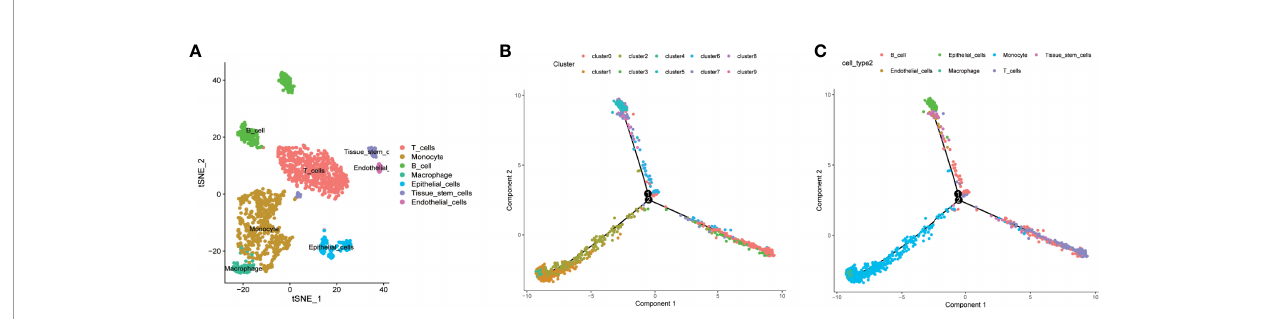
FIGURE 2 | Cell annotation, differentiation trajectory prediction, and pathway enrichment analysis of different branches. (A, B) All 10 clusters of cells in LUAD were annotated by singleR and CellMarker according to the composition of the marker genes. (C) All cells from tumor mass with cellular annotation were projected into a three-dimensional graph with one root (II) and four branches (branches I, III, IV, and V) in the trajectory analysis. Four branches of cells (branches I, III, IV, and V) with distinct differentiation patterns were identi fi ed by